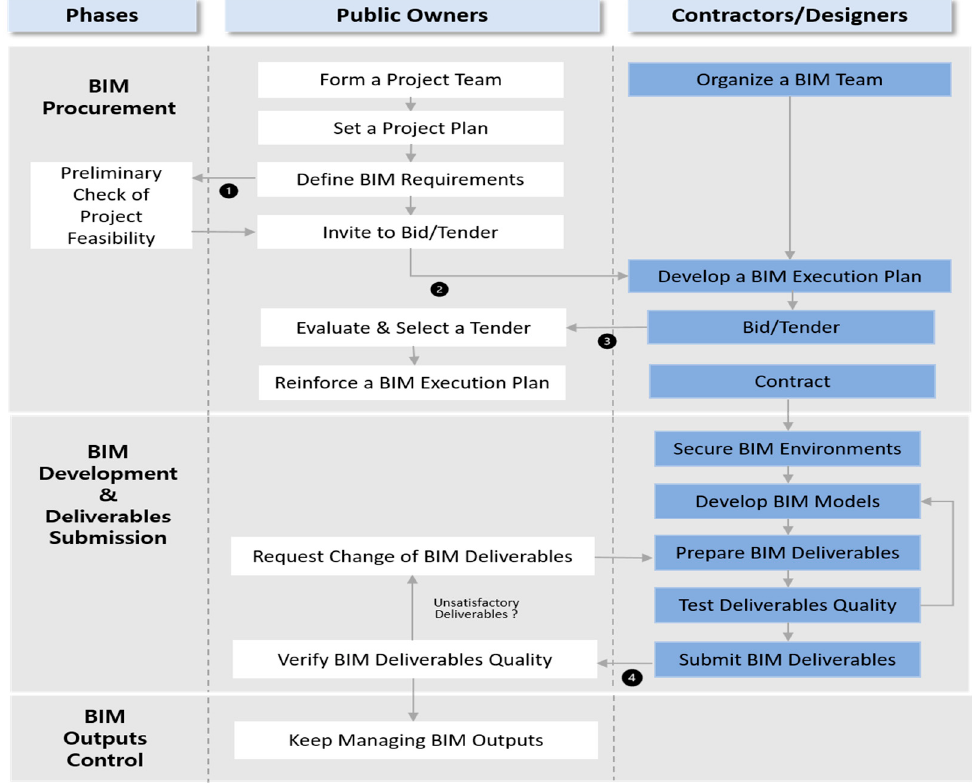
Figure 2. The BIM procurement process at different BIM development